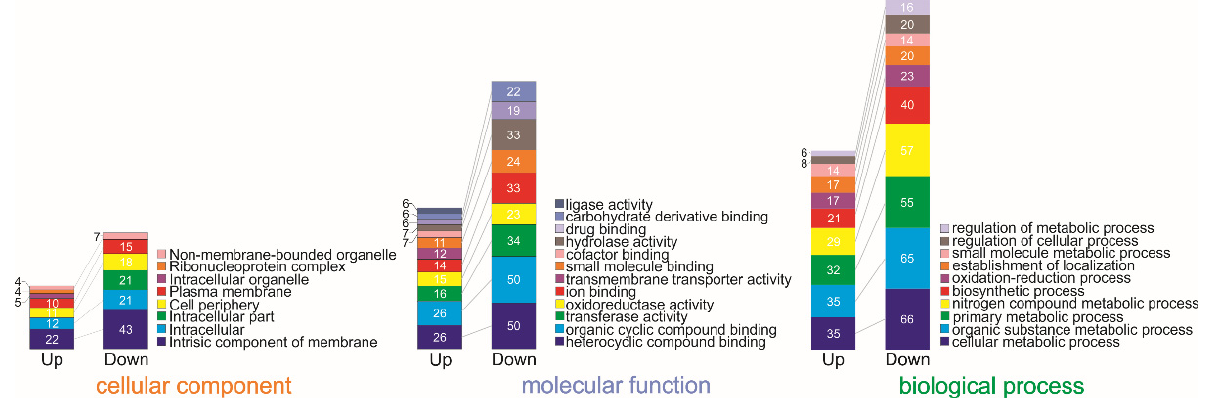
Figure 1. Functional classification of differentially expressed genes according to GO.